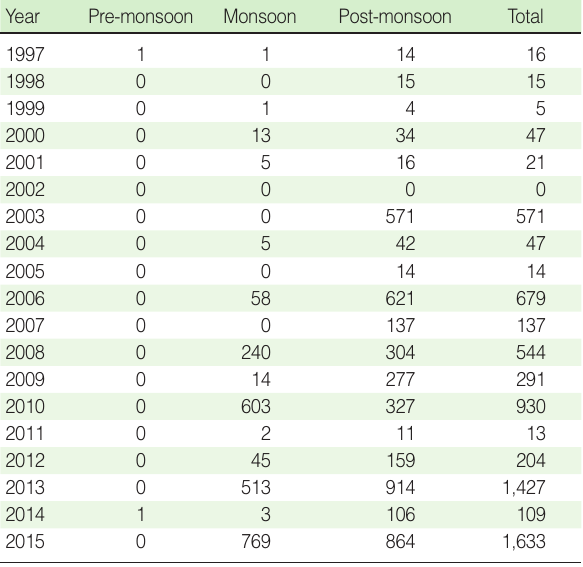
Table 1. Seasonal variation in the number of dengue cases